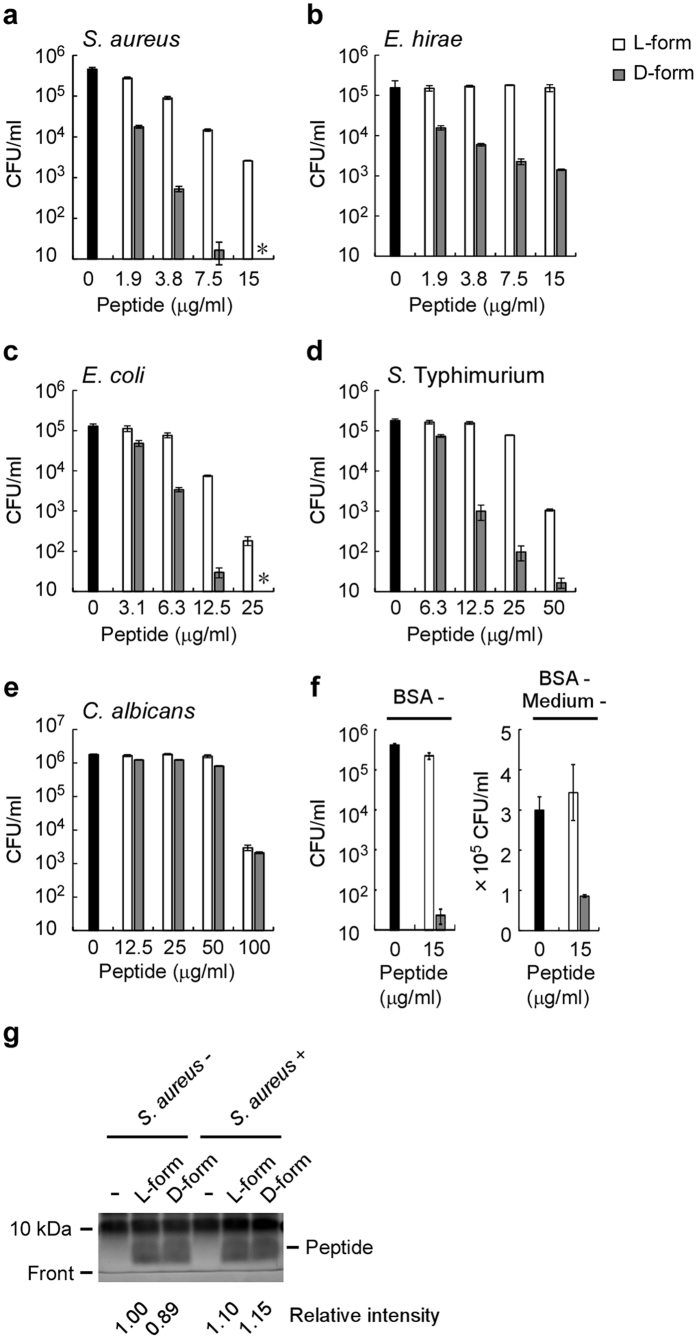
Antimicrobial activities of D-form KLKLLLLLKLK-NH2 to bacteria were higher than those of the L-form counterpart.Antimicrobial activities of D-form KLKLLLLLKLK-NH2 (D-form) and L-form KLKLLLLLKLK-NH2 (L-form) against S. aureus (a,f), E. hirae (b), E. coli (c), S. Typhimurium (d), and C. albicans (e) were examined. (f) Antimicrobial activities were examined in the absence of bovine serum albumin (BSA-) or in the absence of both bovine serum albumin and culture medium (BSA-, medium-). Gray bars and white bars represent CFUs in assay mixtures treated with the indicated concentrations of D-form and L-form peptides, respectively. Black bars represent CFUs in assay mixtures without peptide. The error bars represent the mean ± standard deviations from triplicate plates. Asterisk (*) indicates no bacteria were detected (<10 CFU/ml). Concentrations of dimethyl sulfoxide in the assay mixtures were 0.15% (a,b and f) and 1.0% (c–e). (g) S. aureus (S. aureus+) was treated without (-) or with 15 μg/ml D-form KLKLLLLLKLK-NH2 (D-form) or L-form KLKLLLLLKLK-NH2 (L-form) as performed in (a). Control assay mixtures without S. aureus (S. aureus-) were also prepared. The assay mixtures (10 μl) were subjected to SDS-polyacrylamide gel electrophoresis using Any kDTM precast polyacrylamide gel. Proteins, including KLKLLLLLKLK-NH2 (molecular weight 1321.8), were visualized with Ruby protein gel stain. The full-length gel was shown in supplementary figure 1. Relative intensities of peptide signals were measured using Multi Gauge ver.3 (FUJIFILM), and the values normalized with that of L-form peptide (S. aureus-) were indicated.